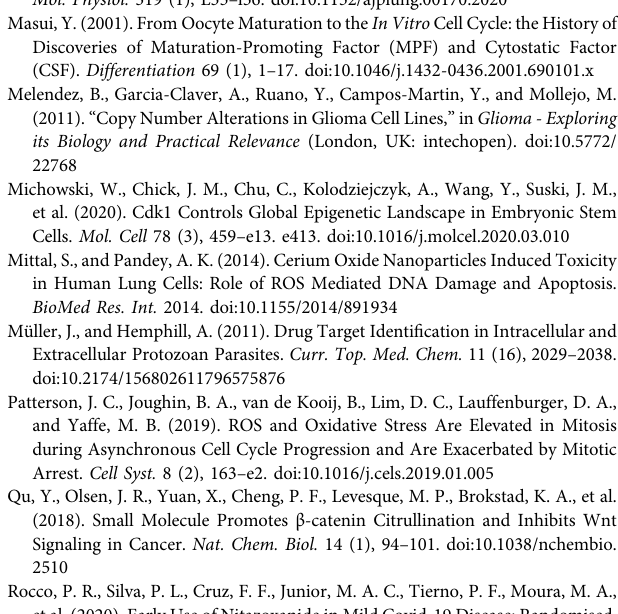
enrichment analysis of top20 target genes. (B) GO molecular function enrichment analysis of top20 target genes. (C) GO cellular component analysis oftop20targetgenes. (D) ThemRNAexpressionofCDK1,CDK2,CDK4,andCDK5 were collected from The Cancer Genome Atlas (TCGA) and Gene Expression Pro fi ling Interactive Analysis (GEPIA) databases. T, tumor; N, normal. (E) Docking diagram of CDK4 and TIZ. Key interactions include hydrogen bonds formed by a